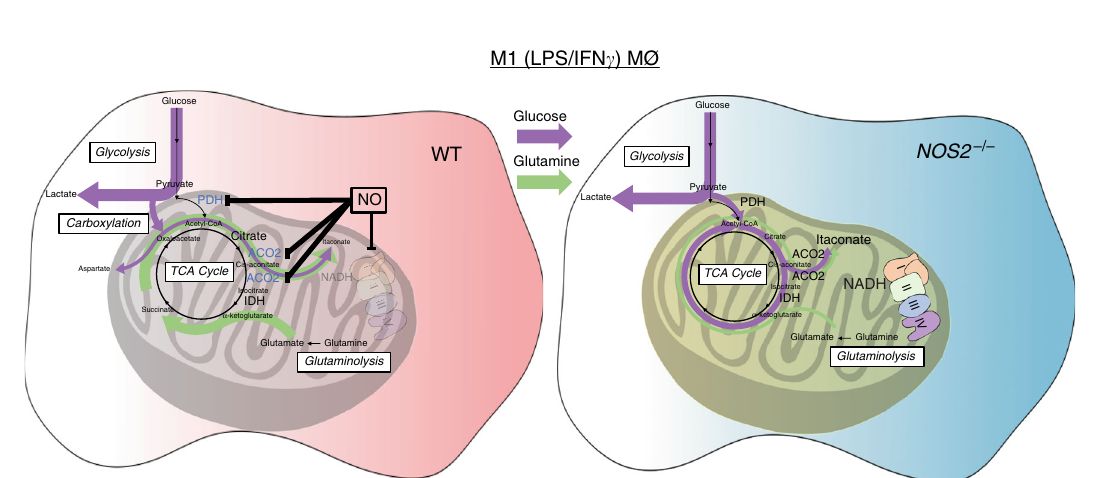
Fig. 8 NO orchestrates metabolic reprogramming in M1 macrophages. Macrophage activation in the presence of Nitric Oxide (NO) results in multiple metabolic rewirings. Aconitase 2 is inhibited and entrance of carbon into TCA cycle via pyruvate dehydrogenase is halted. In turn, compensatory carboxylation and glutaminolysis are enhanced, leading to citrate accumulation and limited itaconate. Because of the breaks, the lack of NADH and reduced substrates leads to inactive mitochondrial complexes. In Nos2 − / − BMDMs glycolytic fl ux is maintained and carbon passage through PDH and ACO2 is intact. In this scenario, production of itaconate is increased and mitochondrial complexes display full functional activity. The arrows represent the general direction of the metabolic fl ow in the system with the speci fi c contribution of glucose (purple) and glutamine (green). PDH pyruvate dehydrogenase, ACO2 mitochondrial aconitase, IDH isocitrate dehydrogenase, LPS lipopolysaccharide, IFN γ interferon γ